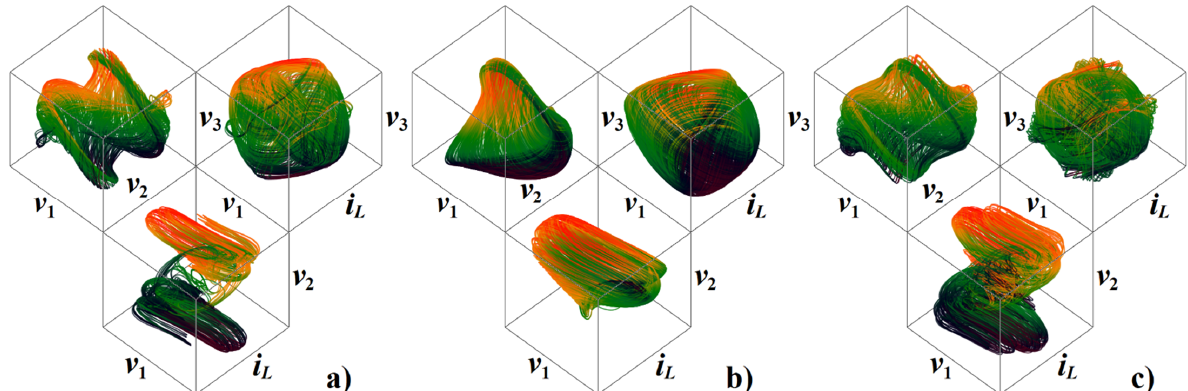
Figure 3. Numerical analysis of third order dynamical system: ( a ) 3D plot of the typical strange attractor generated by (1) with parameter set (7), ( b ) chaotic waveforms in time domain, ( c ) sensitivity of system solution to small changes of the initial conditions plotted with respect to time, ( d ) 3D plot of the typical strange attractor generated by (1) with parameter group (8), ( e , f ) sensitivity of system solution visualized in the state space, see text for details. Ranges for individual state variables in plot ( a ) are v 1  (−4, 4) V, v 2  (−2, 2) V, and i L  (−2, 2) A, axis ranges for plot ( d ) are v 1  (−1, 1) V, v 2  (−2, 2) V, and i L  (−2, 2) A.